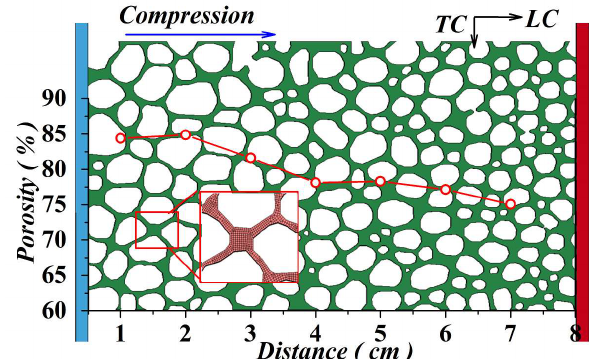
Figure 3. Numerical simulation model of the FG specimen and the variation trend of material porosity.